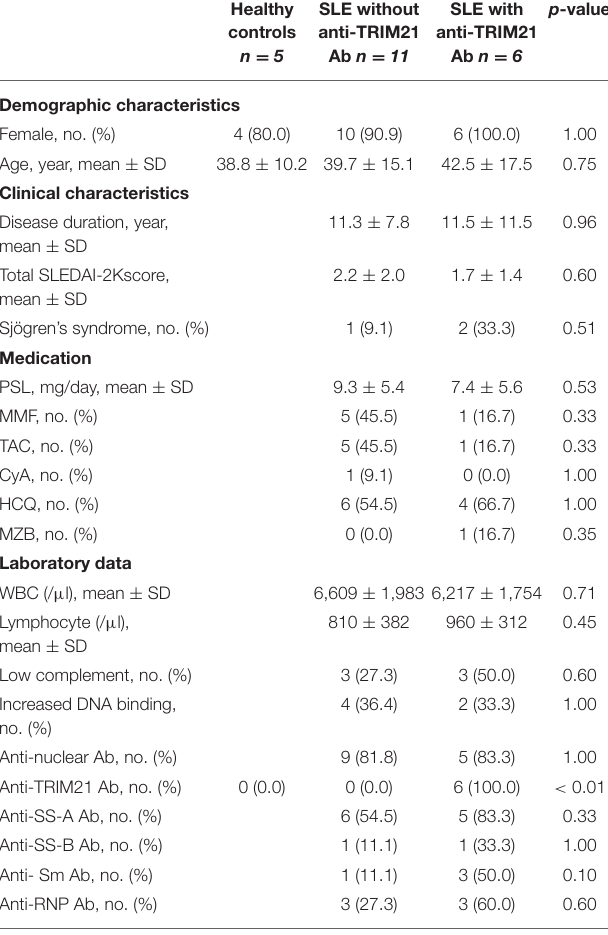
TABLE 2 | Demographic and clinical characteristics in human subjects. Healthy